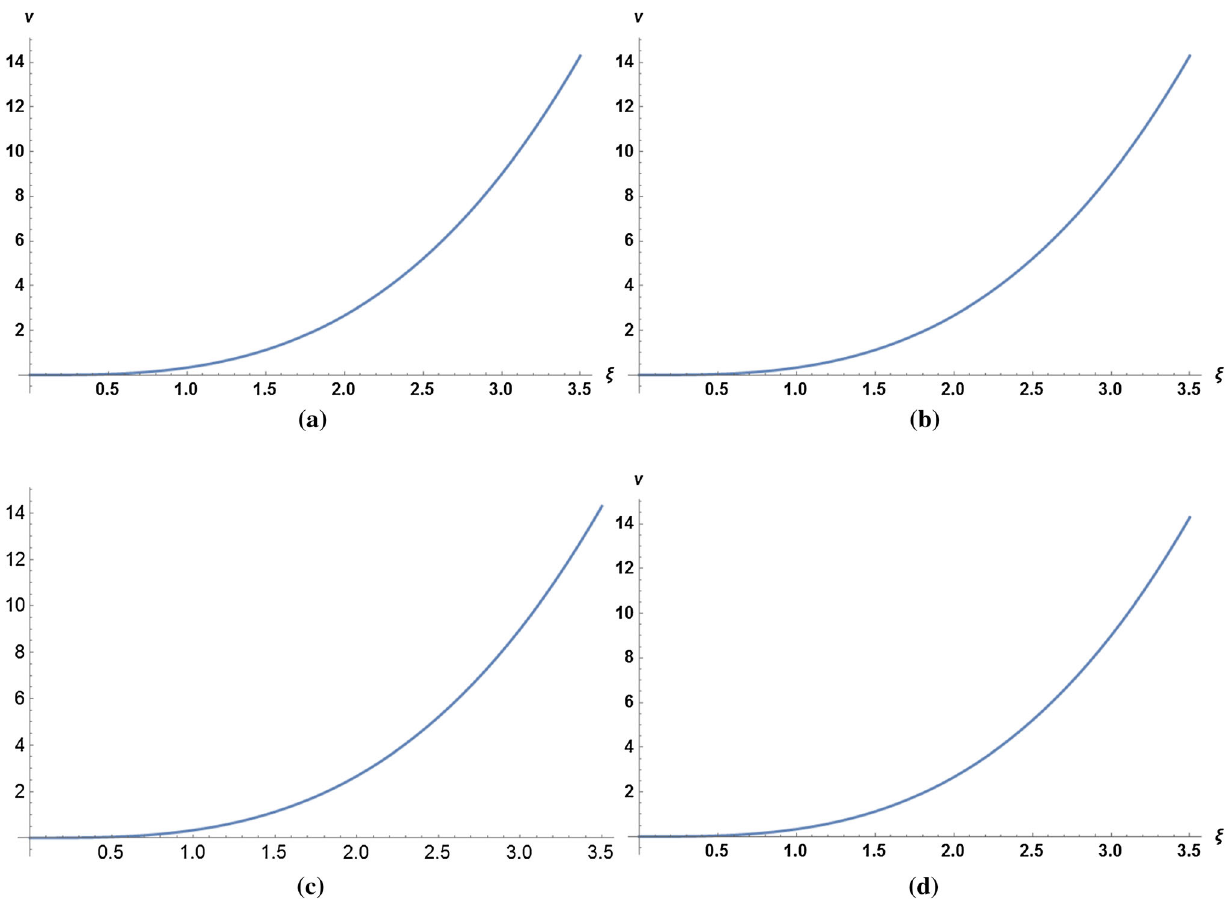
Fig. 4 Graphs between ξ and v ; for α 1 = . 5, n = 1 and α = 10 − 10 (curve a ); α = 2 × 10 − 10 (curve b ); α = 4 × 10 − 10 (curve c ) and α = 8 × 10 − 10 (curve d